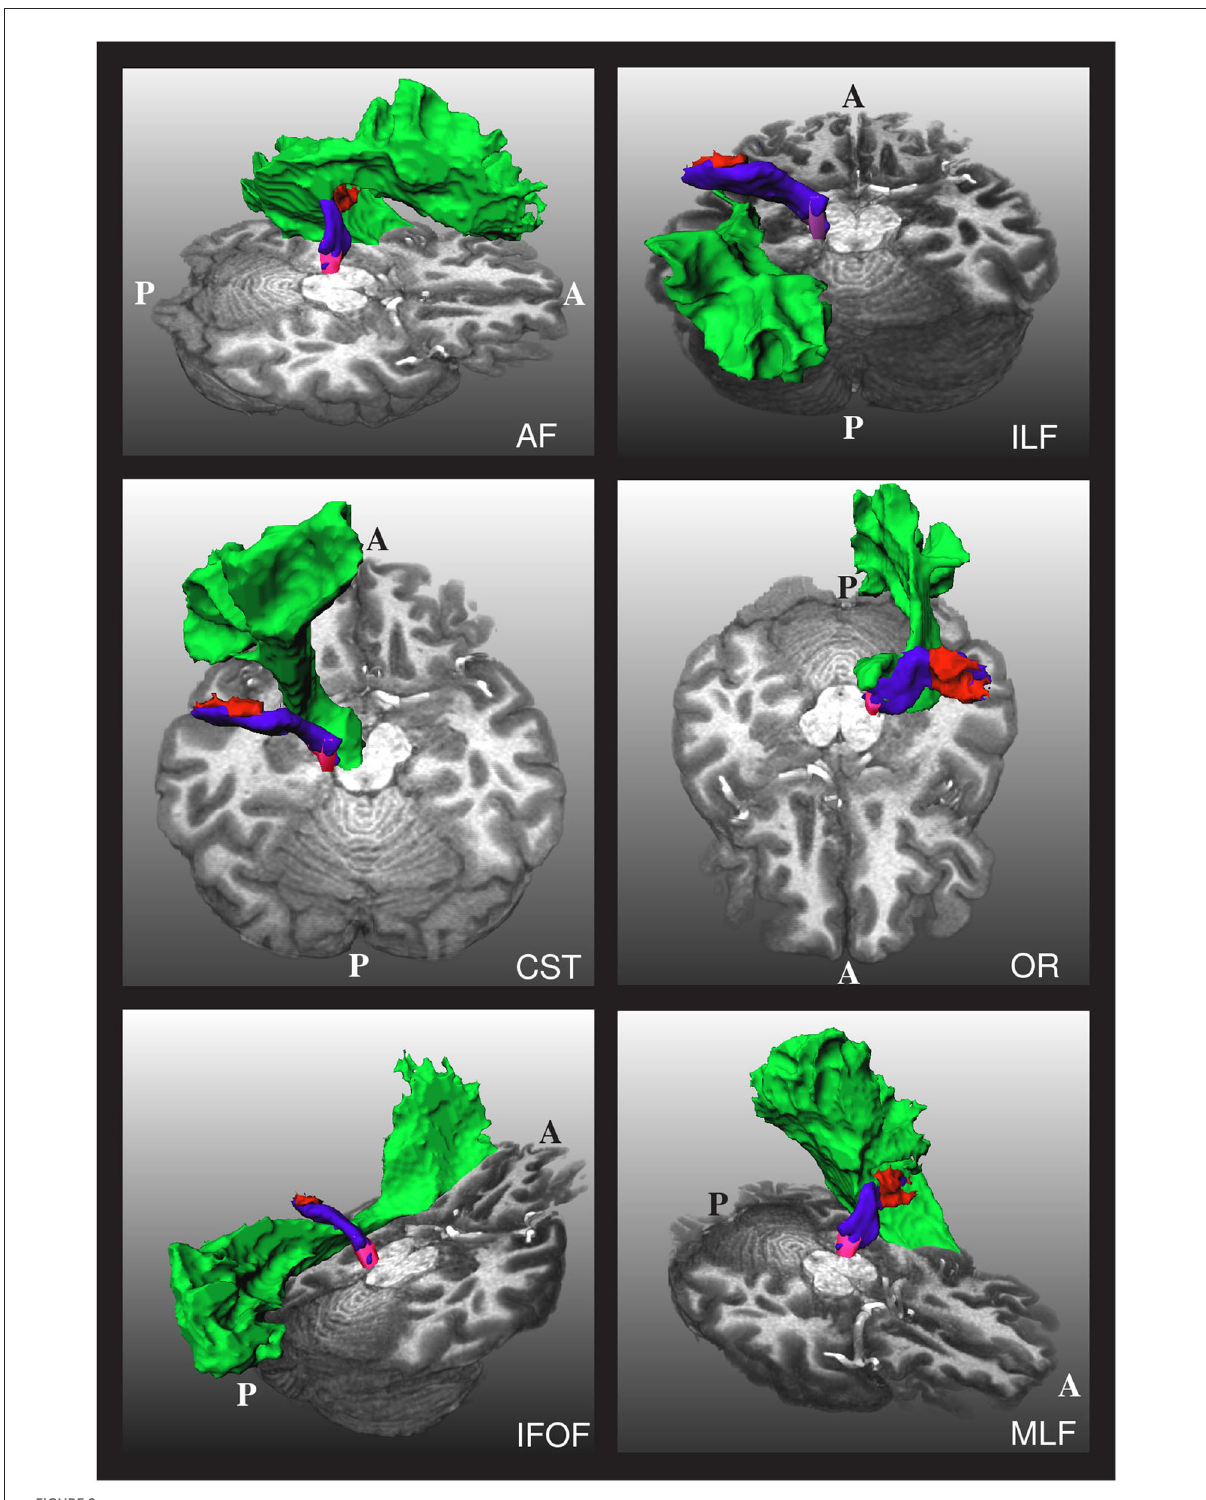
FIGURE2 The relative position of the left acoustic radiation with six nearby fiber bundles for a subject of the human connectome project. The Heschl’s gyrus, medial geniculate nucleus, and acoustic radiation of the left side of the brain are depicted in red, magenta, and blue, respectively. Each of the nearby fiber bundles is depicted in green, one per subfigure. A and P indicate the anterior and posterior sides of the brain, and T1w is used as a reference. The depicted acoustic radiation was computed using the methodology of Section